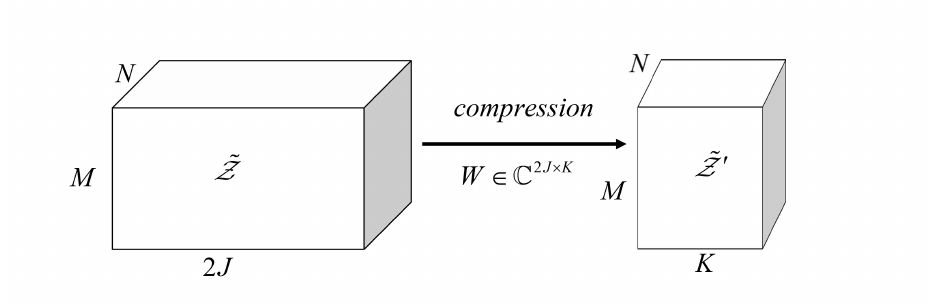
Figure 2. Tensor compression